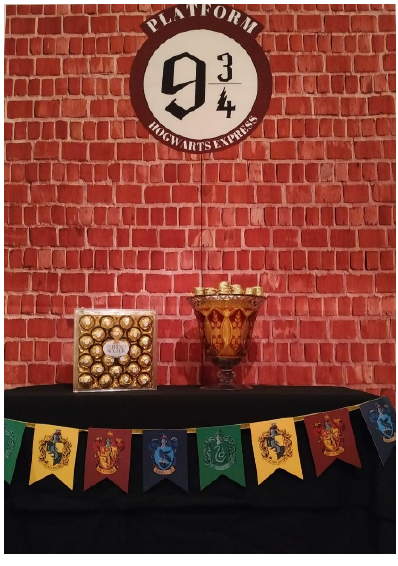
Figure 3. House Cup.